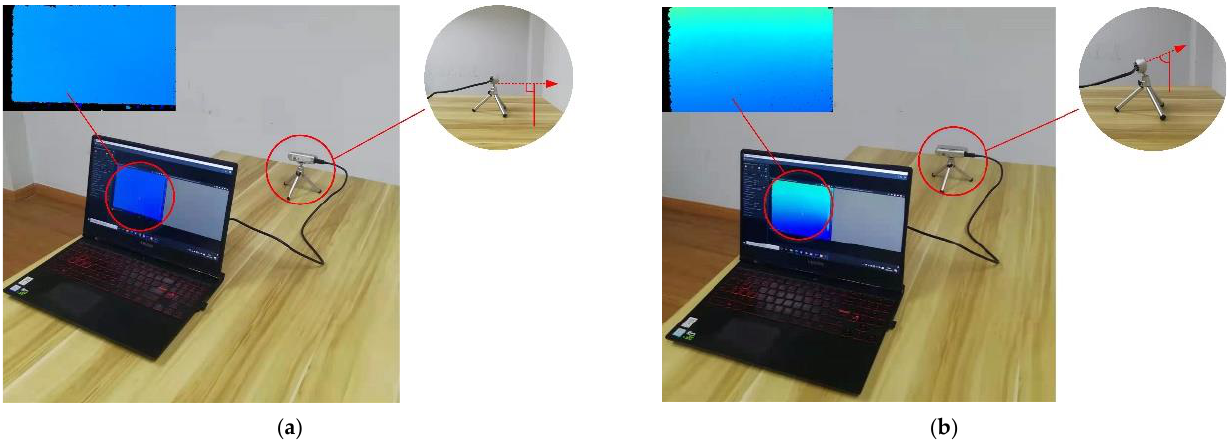
Figure 12. Different camera tilt angles for the white wall depth map. ( a ) The optical axis is perpendicular to the wall. ( b ) The optical axis is not perpendicular to the wall.